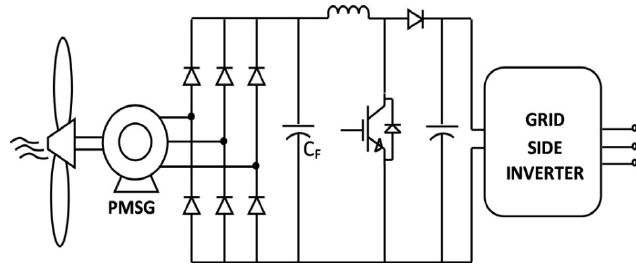
Figure 1. Diode rectifier plus a DC-DC boost stage.